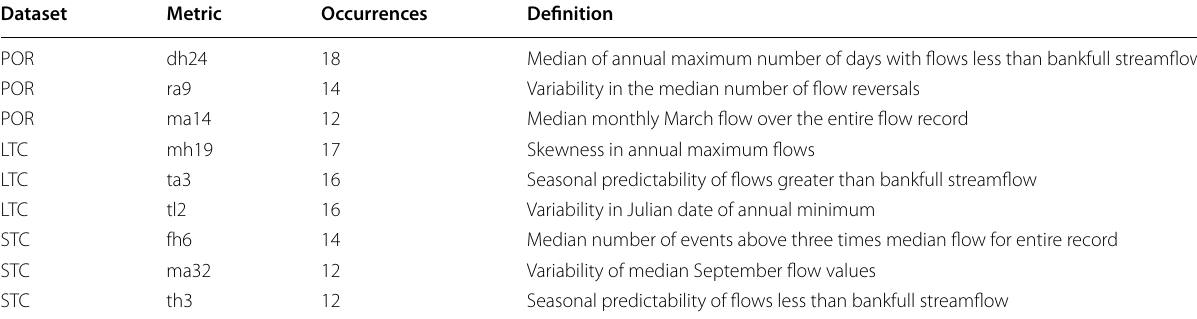
Table 3 Frequency of occurrences and definitions for the three most commonly used hydrologic metrics in final 134 regression models associated with each of three hydrologic